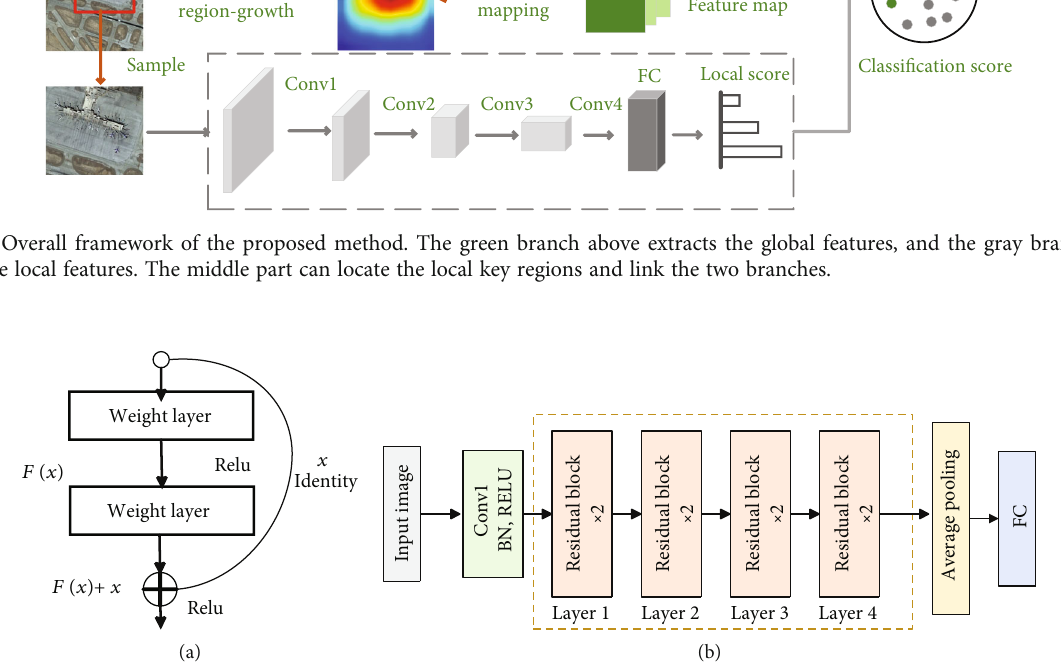
Figure 2: The component of the network. (a) The residual unit. (b) The overall architecture of the baseline network.